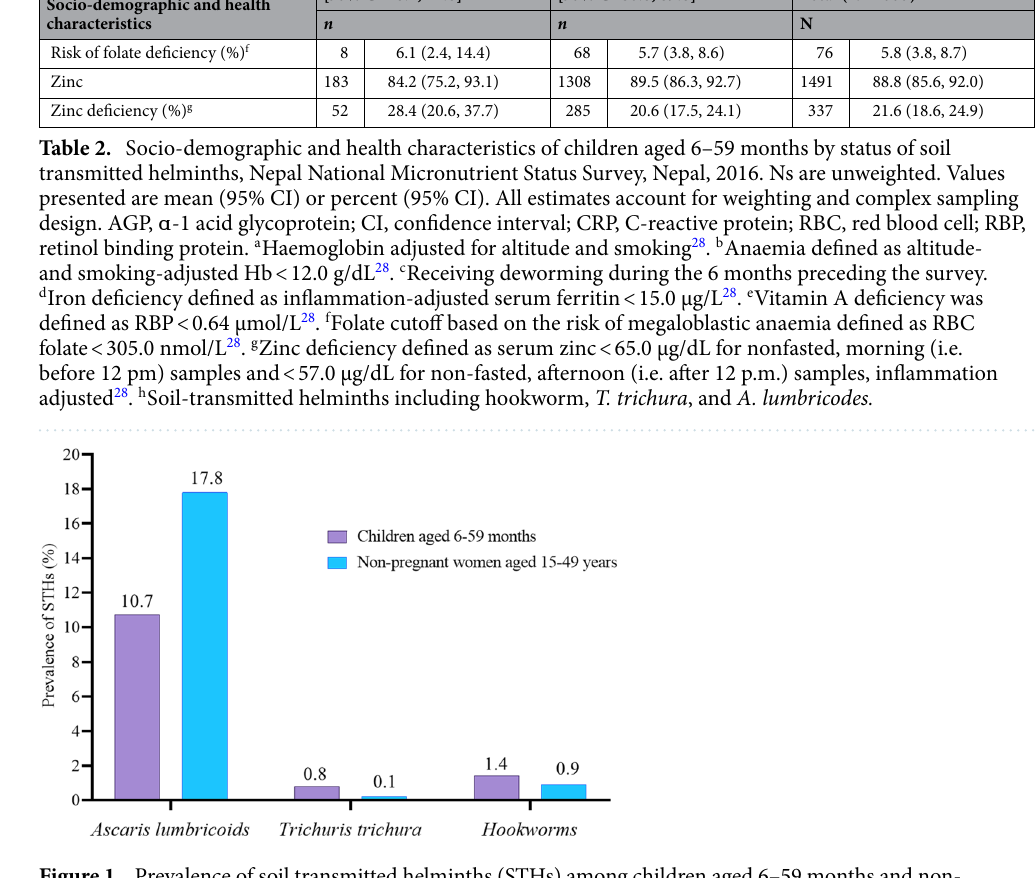
Figure 1. Prevalence of soil transmitted helminths (STHs) among children aged 6–59 months and non- pregnant women aged 15–49 years, Nepal National Micronutrient Status Survey, 2016. Potential